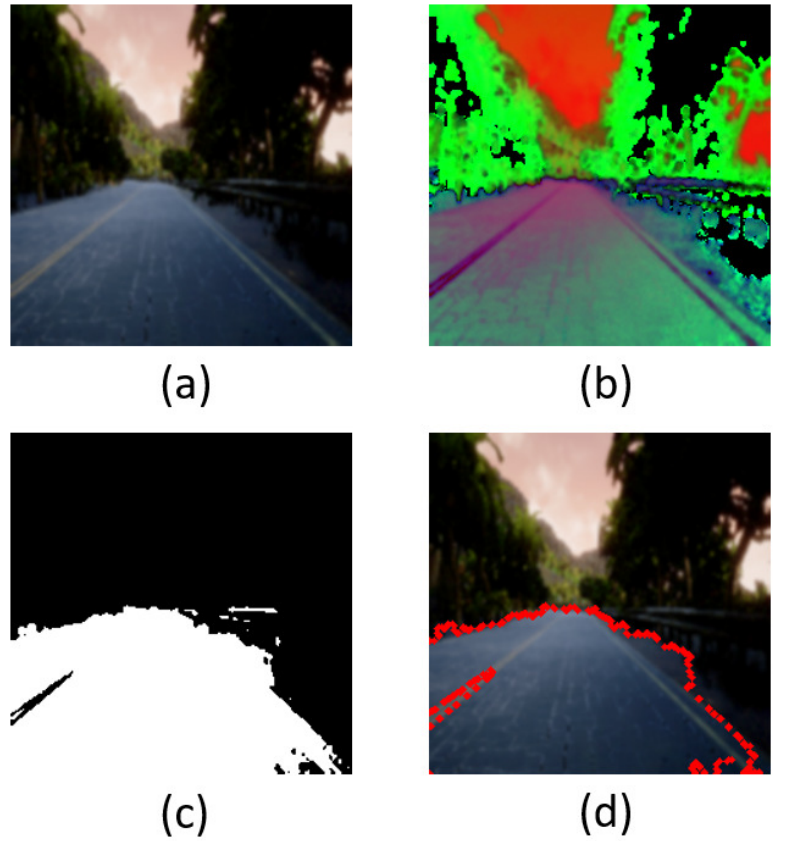
Figure 6. An example of an image to obtain the measure of the road area: ( a ) original image; ( b ) converted to the HSV color space; ( c ) binarization; ( d ) result with the contour